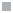
Effect of Sb on the total phenols content (A), phenilpropanoid glycosides (B), flavonoids (C), and PPO activity (D) in roots (□) and leaves (■) of H. annuus plants. Data from 5 independent experiments, each one carried out in triplicate (different letters indicate significant differences at p<0.05, Mann-Whitney U-test).